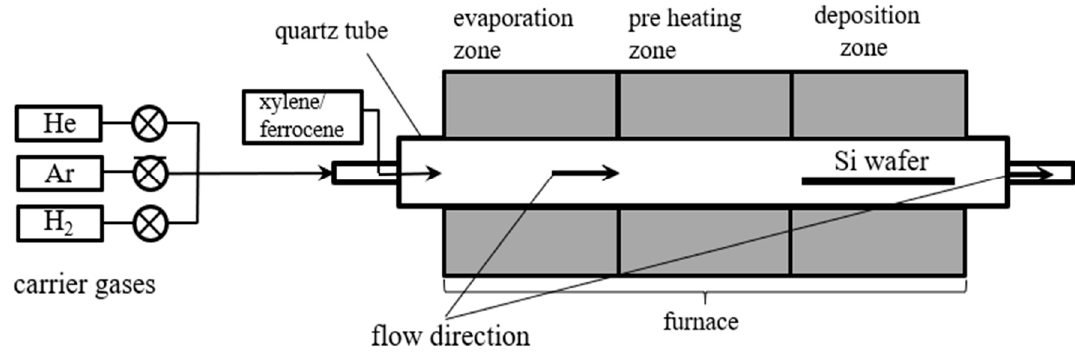
Figure 1. Catalytic chemical vapor deposition (CCVD) system for ferromagnetic carbon nanotubes synthesis.